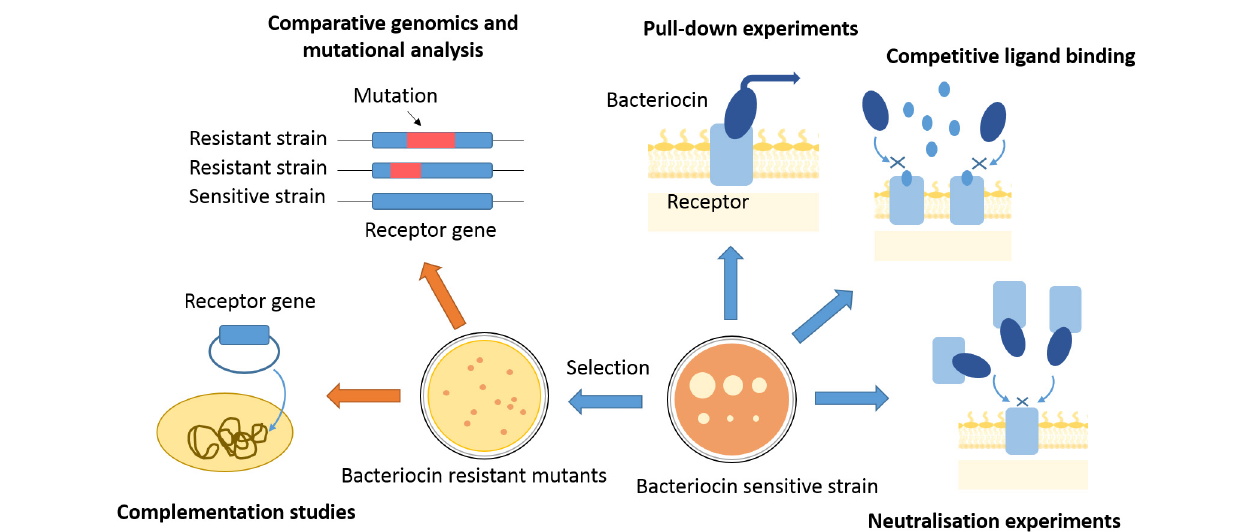
FIGURE 2 | Approaches to finding bacteriocin translocon components. Translocon components can be isolated from membranes of sensitive strains by use of affinity tagged bacteriocins as bait. Competitive ligand binding or bacteriocin binding to a purified translocon component can inhibit bacteriocin activity and give indications about proteins engaged in bacteriocin entry. Bacteriocin-resistant mutants can be selected by use of high bacteriocin concentrations, or generated by transposon mutagenesis. Genomes of resistant mutants can further be analyzed for mutations underlying the resistance phenotype, which can give gene candidates for translocon components. A component of bacteriocin entry has to be further confirmed by complementation studies, where bacteriocin sensitivity is re-established once a resistant mutant is transformed with a gene of